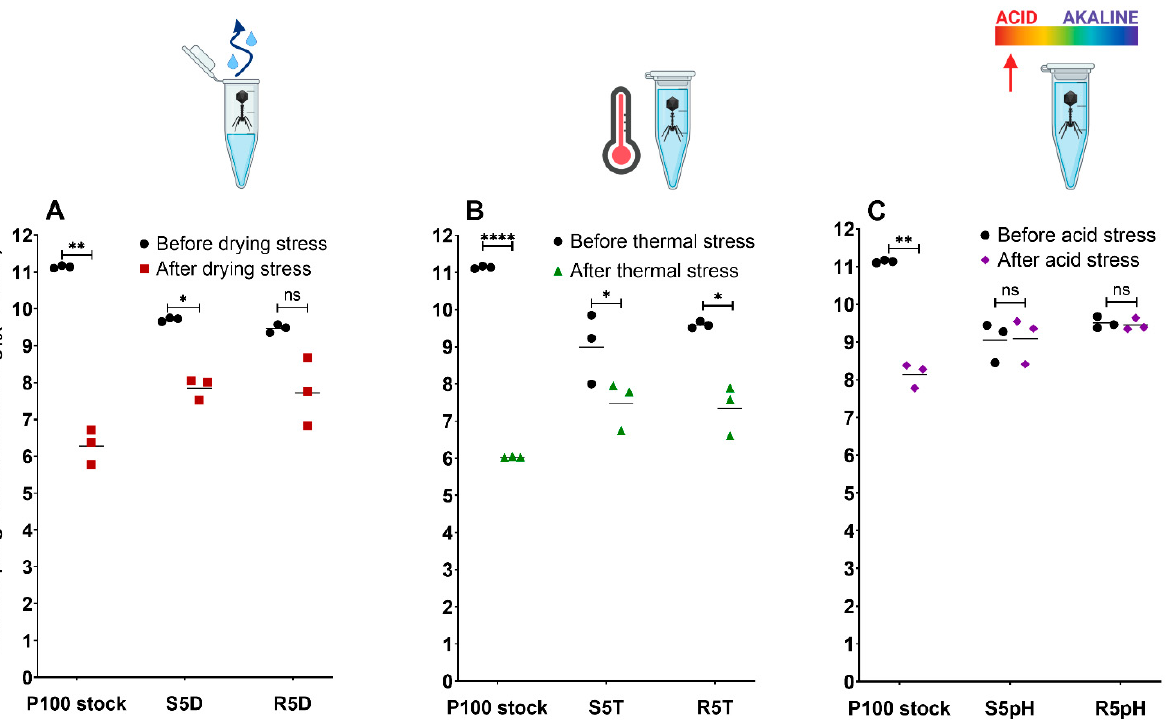
Figure 2. Measured concentrations of viable phage in the P100 stock, a sample that has undergone 5 cycles of selection for a given stress, and a sample that has undergone 5 cycles of selection followed by 5 cycles of propagation without exposure to stress before and after exposure to: ( A ) desiccation for 4 h; ( B ) temperatures of 60 °C of 1 h; and ( C ) estimated pH of 2.65 for 1 h. Results are shown as the individual results of triplicate experiment, where the geometric mean has been marked. Phage concentration prior to exposure presented in black and concentration after exposure presented in colour. Significant differences in phage concentration before and after exposure to a given stress are marked as * p ≤ 0.05, ** p ≤ 0.01, and **** p ≤ 0.0001. Nomenclature: n.s.: not significant; S5D: P100 sample that underwent 5 cycles of desiccation selection; S5T: P100 sample that underwent 5 cycles of elevated temperature selection; S5pH: P100 sample that underwent 5 cycles of low-pH selection; R5D: S5D sample that was propagated 5 times in the absence of stress; R5T: S5T sample that was propagated 5 times in the absence of stress; R5pH: S5pH sample that was propagated 5 times in the absence of stress. Icons from Biorender.com.